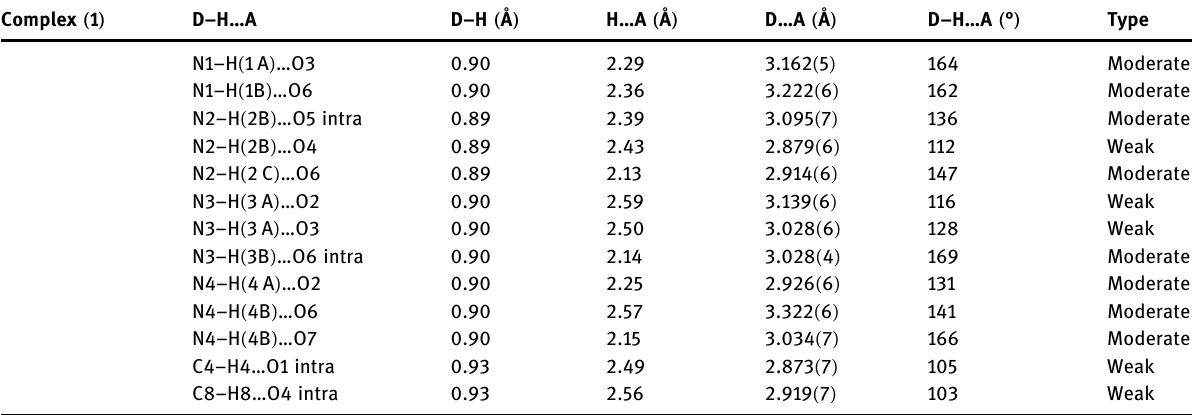
Complex ( 1 ) D – H … A